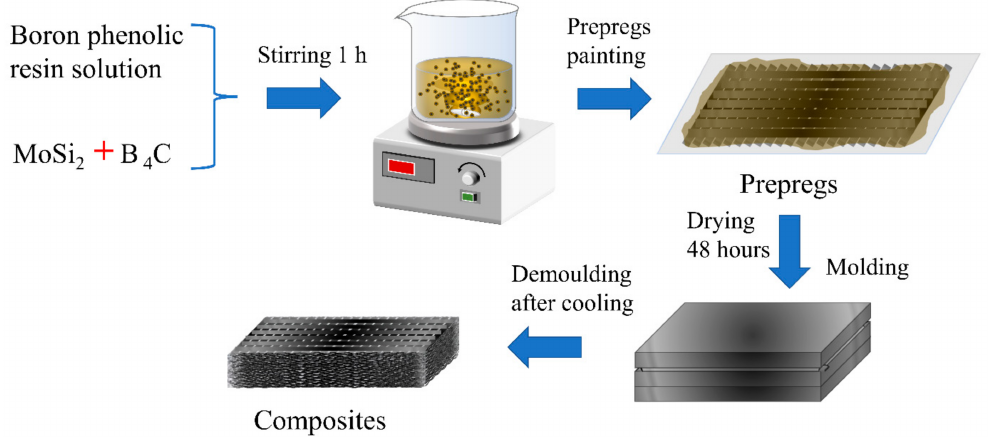
Figure 1. Preparation process of